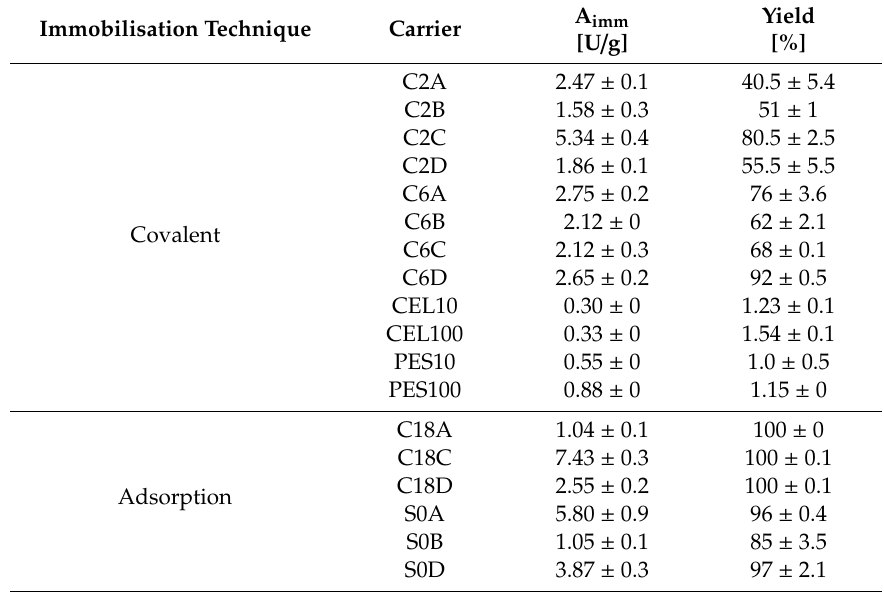
Table 1. Influence of the type of carrier and immobilisation technique on the activity of immobilised LAC from Pleurotus ostreatus [U / g] and yield of protein immobilisation [%]—screening test. Immobilisation